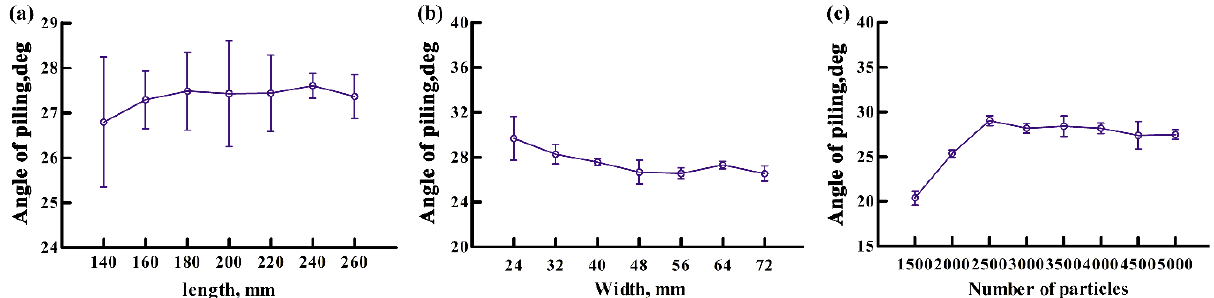
Figure 9. Variations of the angle of piling with the ( a ) length and ( b ) width of the piling box and ( c ) the amount of particles in the “piling angle” simulations for J-17.